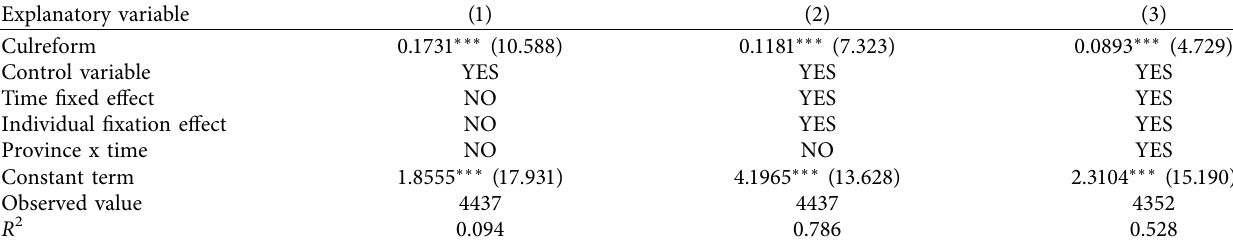
Table 4: Results of controlling the fixed effect of province-time.